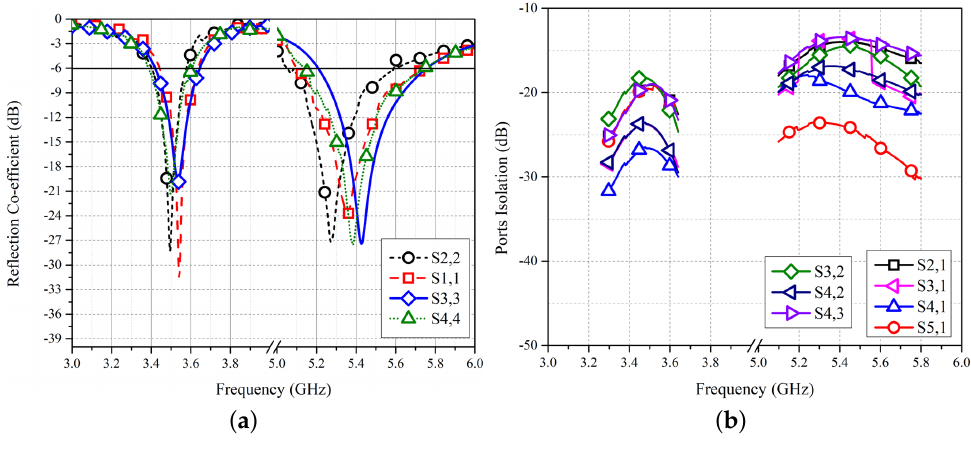
Figure 8. Measured S-parameters of the MIMO antenna system. ( a ) Reflection coefficient; ( b ) ports